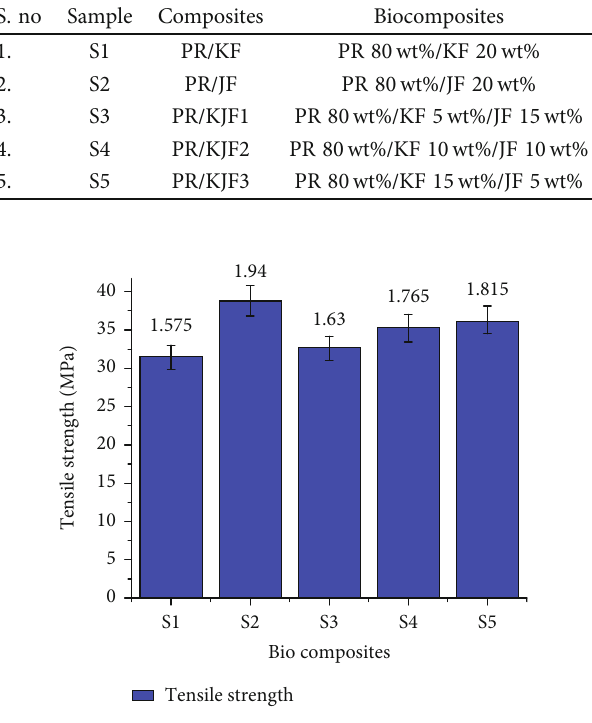
Figure 1: Variations of tensile strength with KF/JF fi ber biocomposites.